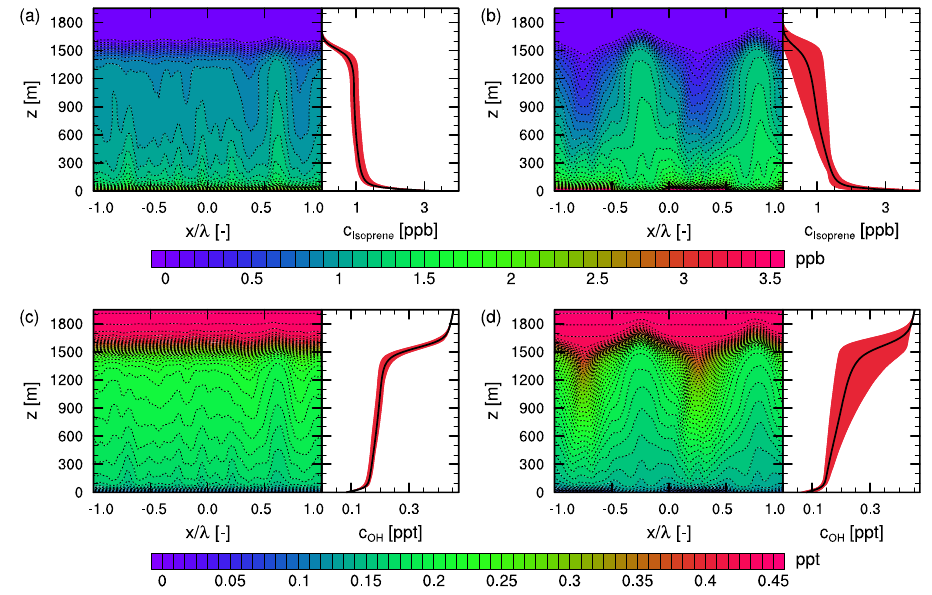
Fig. 14. Isoprene and OH concentrations for numerical experiments UNO (a, c) and HNO (b, d) . They are identical to HOM and HET, respectively, except for the initial NO 2 concentration above 1000m (free troposphere). Each figure has two panels. The first shows the variables averaged over the fourth hour of simulation time and the y-direction, while the second panel shows the additional average in the x-direction. The red area in the second panel shows the variability in the x-direction of the temporal and y averaged values. The concentration of isoprene, c Isoprene , is shown on top (a, b) and the concentration of the hydroxyl radical, c OH , at the bottom (c, d) . The x-coordinate is scaled by the length scale of heterogeneity, λ , which is twice the patch